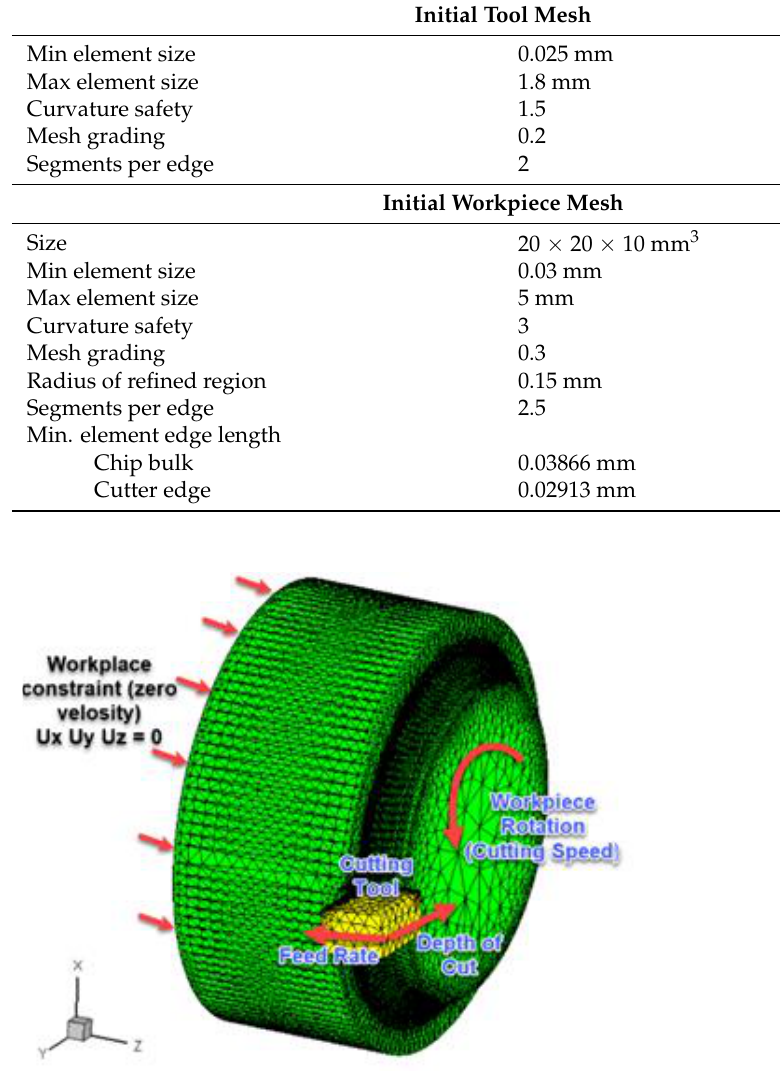
Figure 3. The mesh structure and boundary conditions of the FEM model. Table 7. The JC parameters of AISI 52100 bearing steel